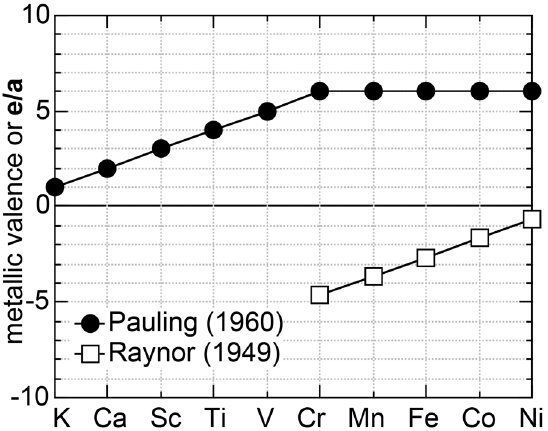
Figure 1. Metallic valence or e/a proposed by Pauling [10] and Raynor [8] for elements in the Period 4 including 3d-transition metals [11].